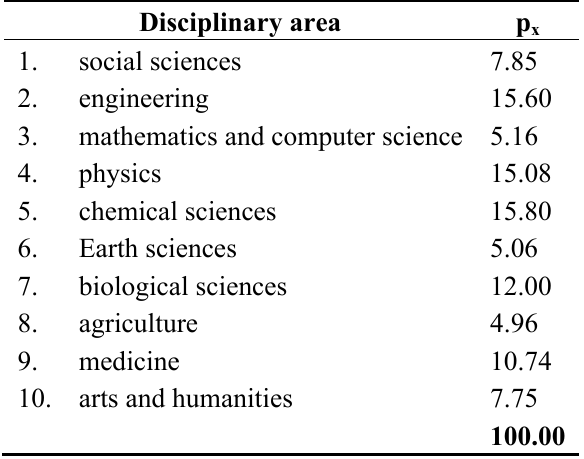
Table 3. Disciplinary areas and their desired